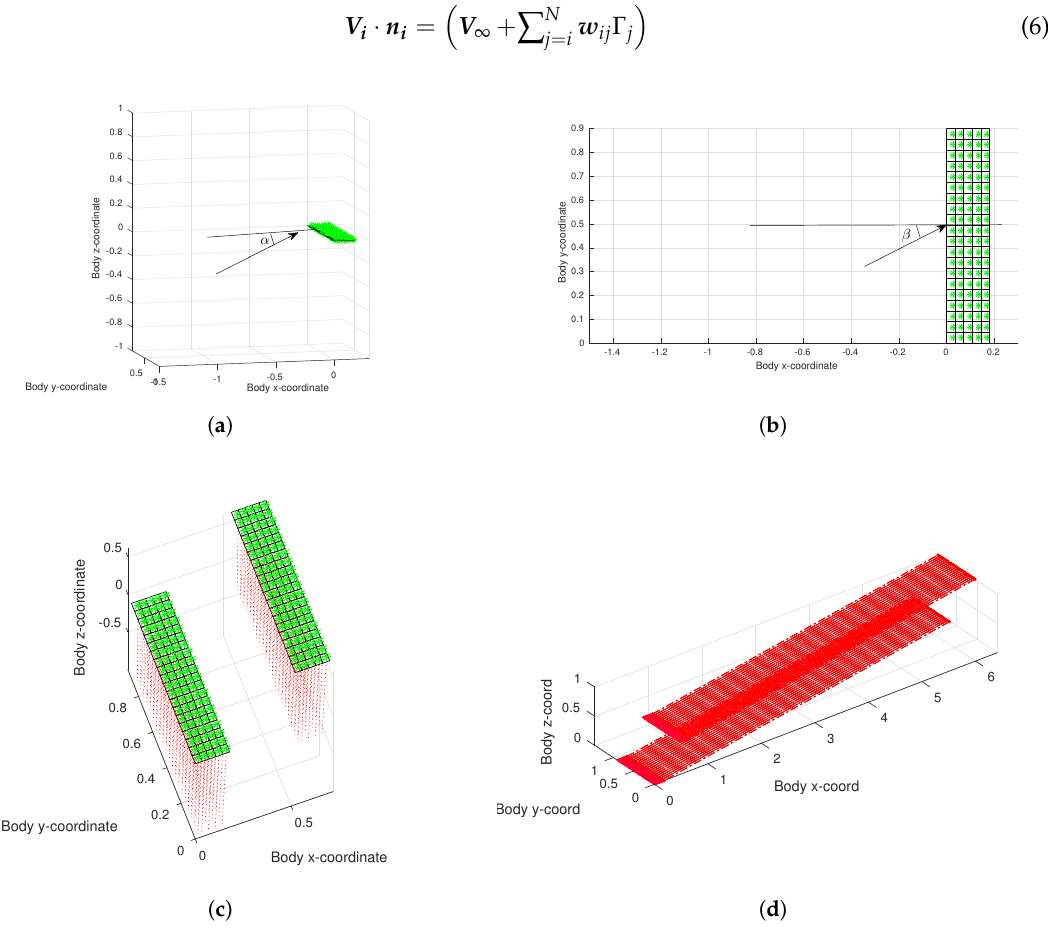
Figure 2. ( a ) Normal vectors (in red) and collocation points on wing surface (green); ( b ) free-stream wake of the lifting surface; ( c ) schematic of angle of attack ( α ) with arrow showing the direction of free-stream velocity (isometric view); and ( d ) schematic of angle of side-slip ( β ) with arrow showing the direction of free-stream velocity